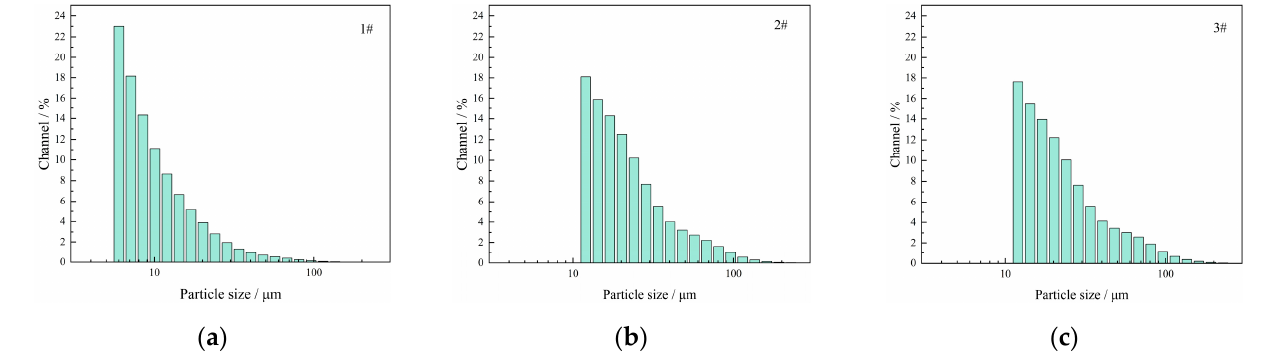
Figure 16. Particle size distribution of thickening components with different formulations: ( a ) 1# thickening component; ( b ) 2# thickening component; ( c ) 3# thickening component.